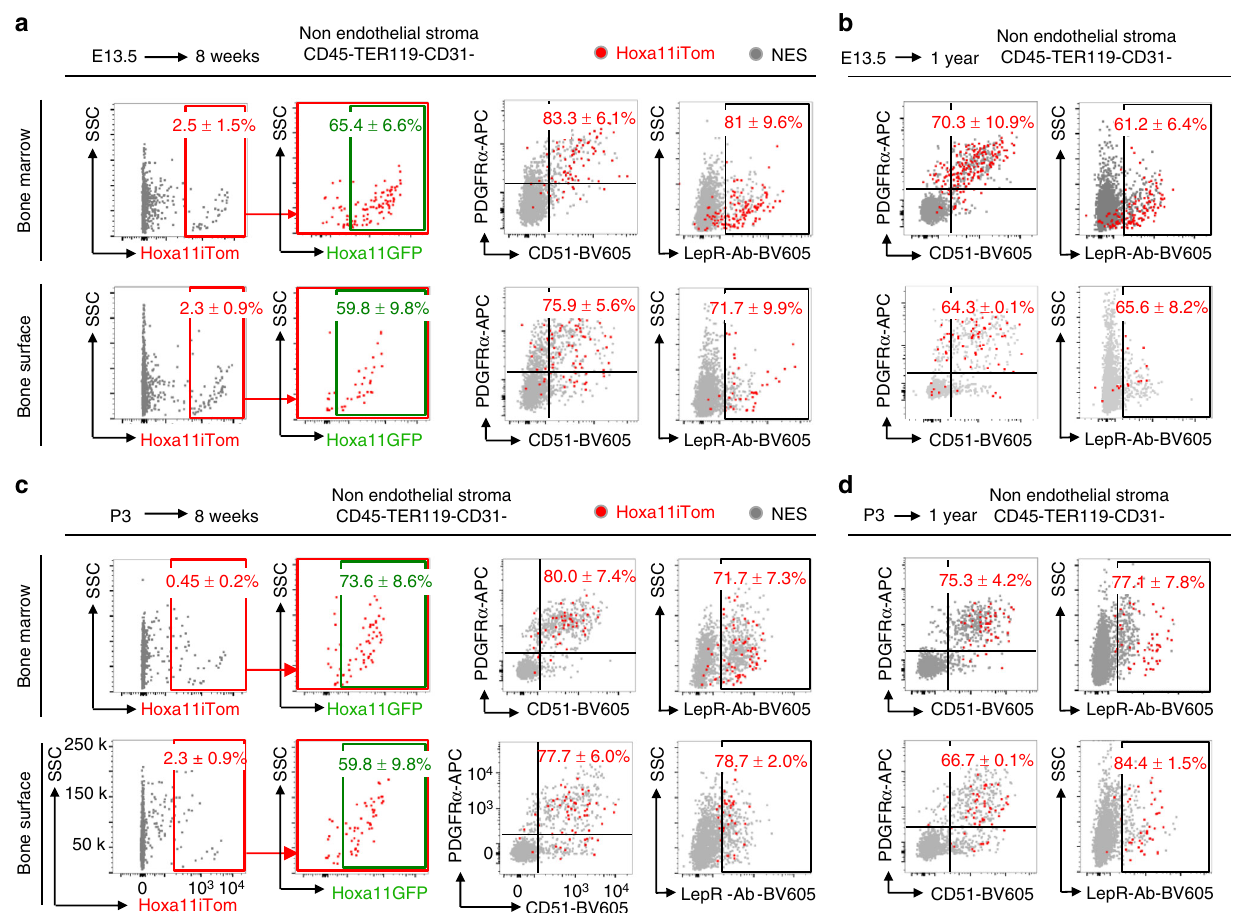
Fig. 5 Hoxa11 -lineage-marked progenitors are maintained throughout life. ( a , b ) Pregnant dams received tamoxifen at E13.5 and resulting Hoxa11eGFP; Hoxa11-CreER T2 ;ROSA-tdTomato mice were chased to ( a ) 8 weeks ( n = 3) or ( b ) 1 year ( n = 4). P3 pups received tamoxifen and Hoxa11eGFP;Hoxa11-CreER T2 ; ROSA-tdTomato mice were chased to ( c ) 8 weeks ( n = 6) or ( d ) 1 year ( n = 3). Flow cytometry analyses of non-hematopoietic, non-endothelial stromal compartment (CD45-TER119-CD31-, NES) in bone marrow (top panels), and bone surface (bottom panels). a , c First panel: Hoxa11 lineage-marked cells ( x - axis: Hoxa11iTom), second panel: analysis of Hoxa11iTom positive gate (red) for Hoxa11eGFP expression, third panel: co-expression analysis of PDGFR α / CD51, fourth panel: co-expression analysis of Leptin Receptor (LepR-Ab). b , d Left: co-expression analysis of PDGFR α /CD51, right: co-expression analysis of Leptin Receptor (LepR-Ab). Percentages re fl ect proportion of Hoxa11iTom population in identi fi ed gate. Gray dots: total non-endothelial stroma (NES), red dots: Hoxa11iTom. ‘ n ’ values indicate pooled cells from radius and ulna of one forelimb from biologically independent animals for each time point. All data presented as mean ± standard